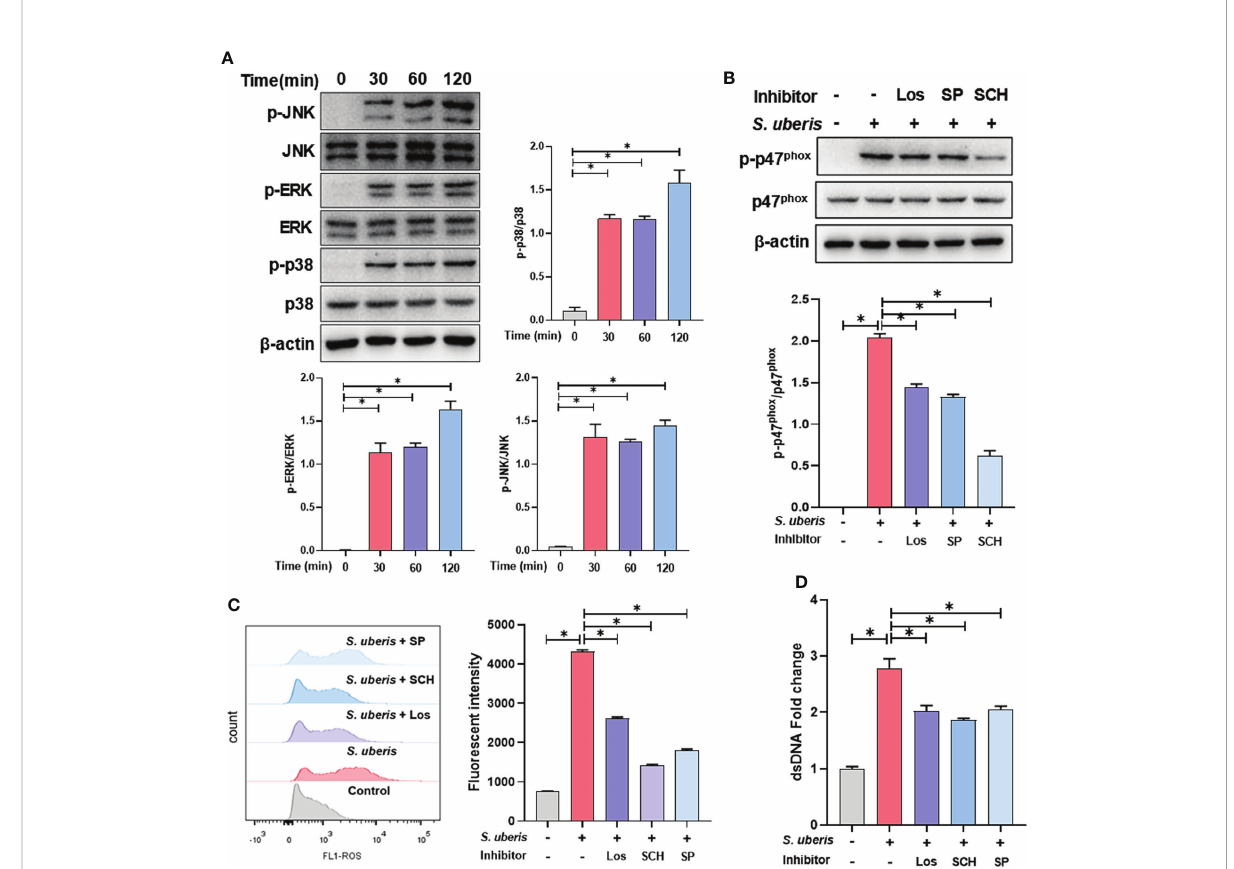
FIGURE 3 MAPK signaling pathway is involved in S. uberis -induced NADPH oxidase activation and ROS production. The neutrophils were pretreated with Losmapimod (Los, 20 m M), SCH772945 (SCH, 0.5 m M) and SP6001255 (SP, 10 m M) for 1 h before infected with S. uberis at MOI of 10. (A) Immunoblot and statistical analysis of neutrophil p38, ERK and JNK proteins and phosphorylated proteins. (B) Immunoblot and statistical analysis of neutrophil p47 phox proteins and phosphorylated proteins at 2 h. (C) The Intracellular ROS level evaluated by Flow Cytometry at 2 h. (D) The dsDNA content in supernatant at 4 h. Data are presented as mean ± SEM (n = 3). * P >